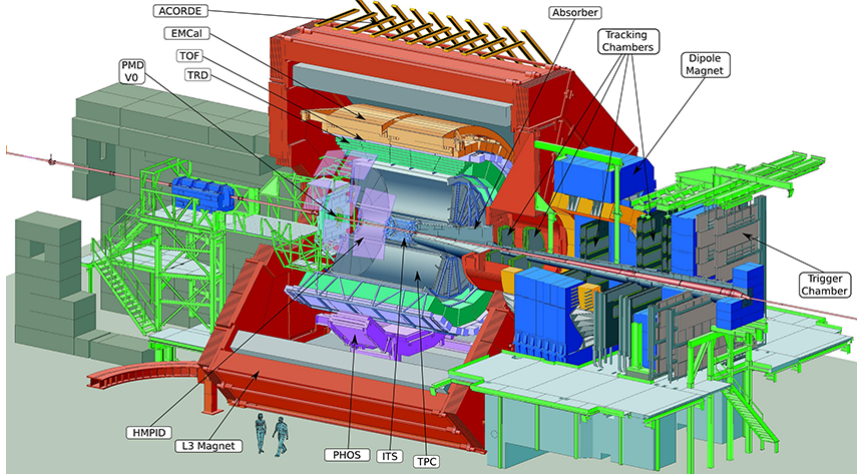
Figure 1. Schema of A Large Ion Collider Experiment